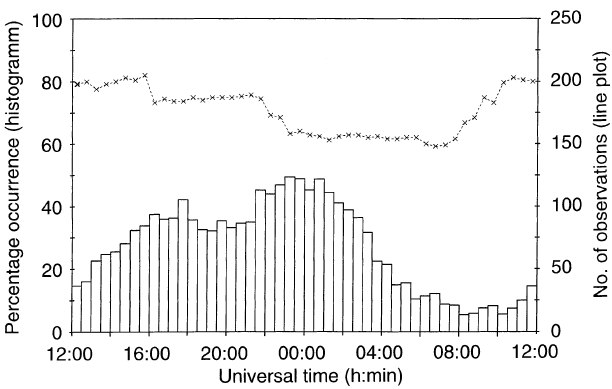
Fig. 1. Diurnal distribution of ion frictional heating at 312 km altitude, derived from over 4000 h of field-parallel EISCAT UHF common programme observations taken between 1984 and 1995. The histogram represents the percentage occurrence of ion frictional heating as a function of universal time, with a bin width of 30 min; the line plot indicates the number of observations of each half-hour bin